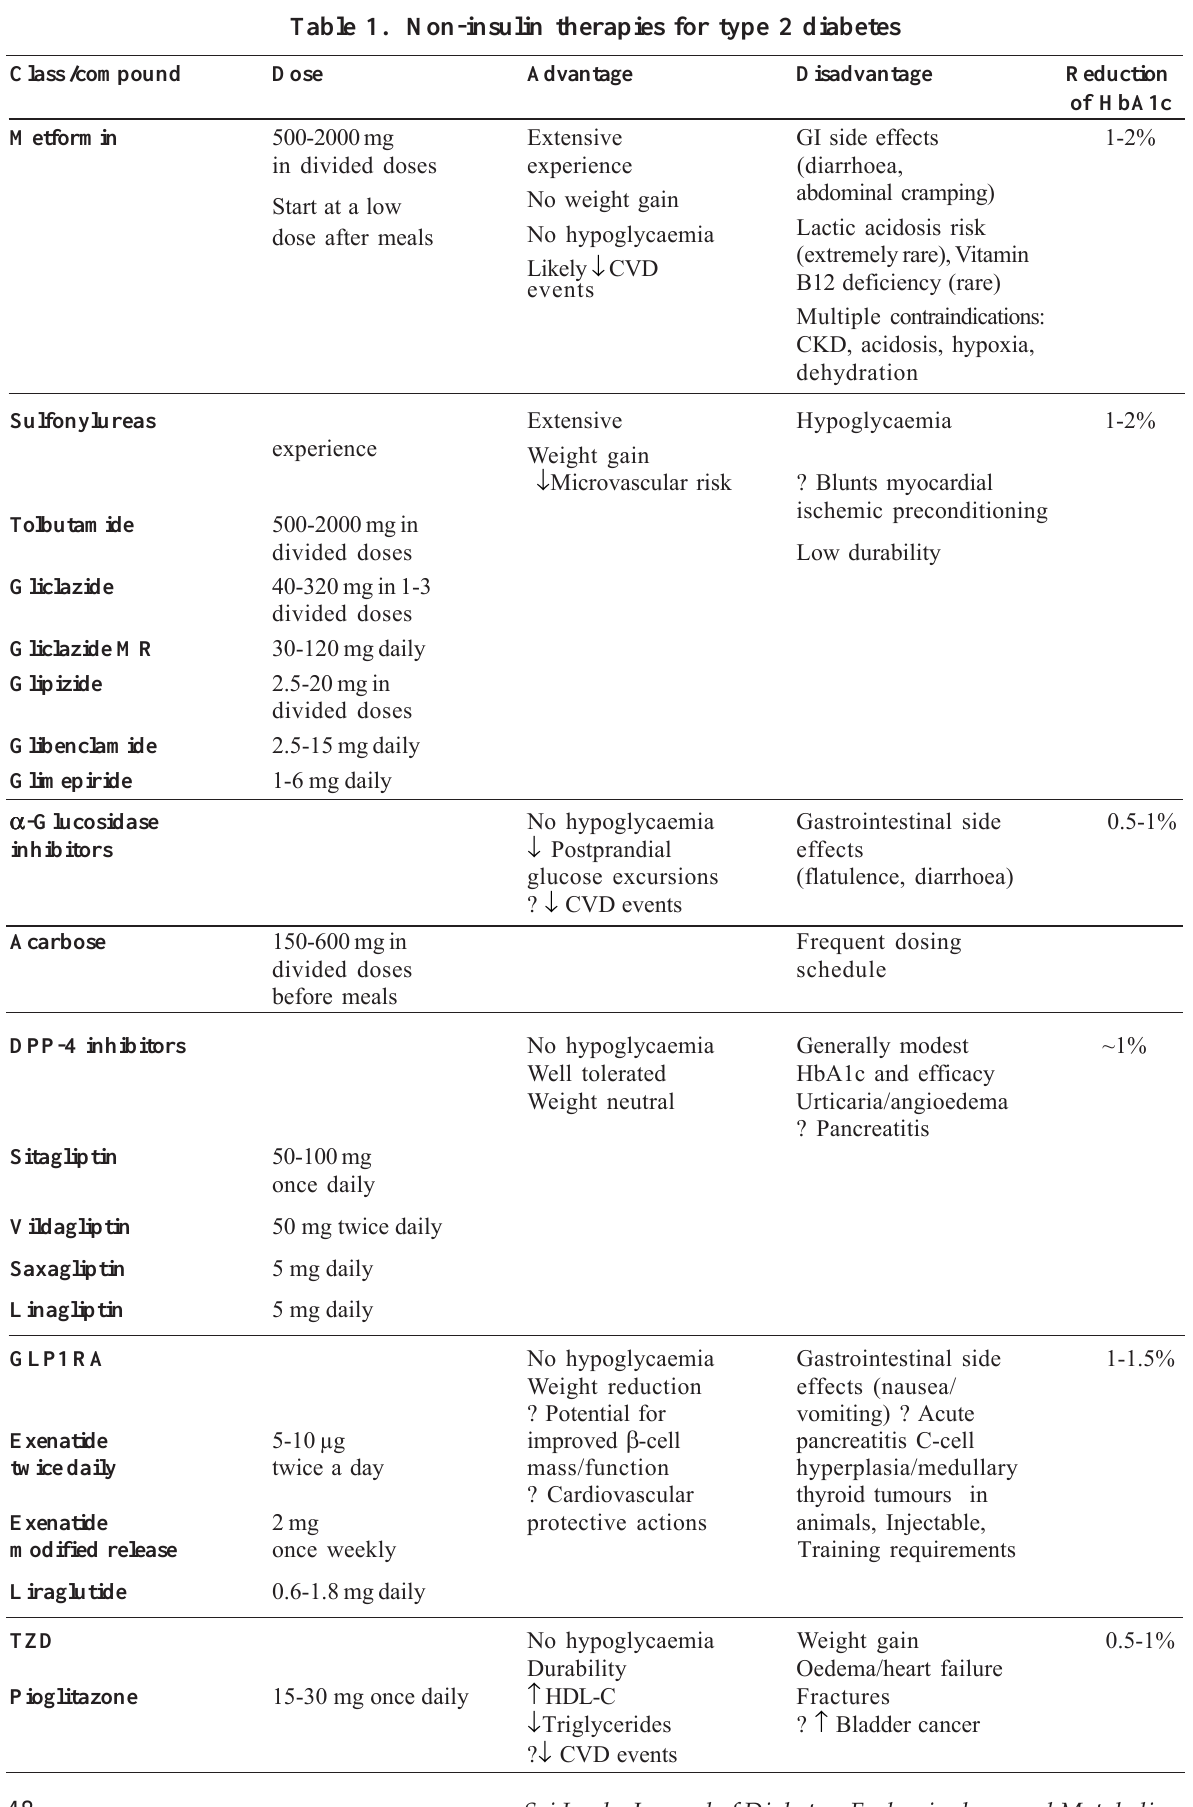
Table 1. Non-insulin therapies for type 2 diabetes Class